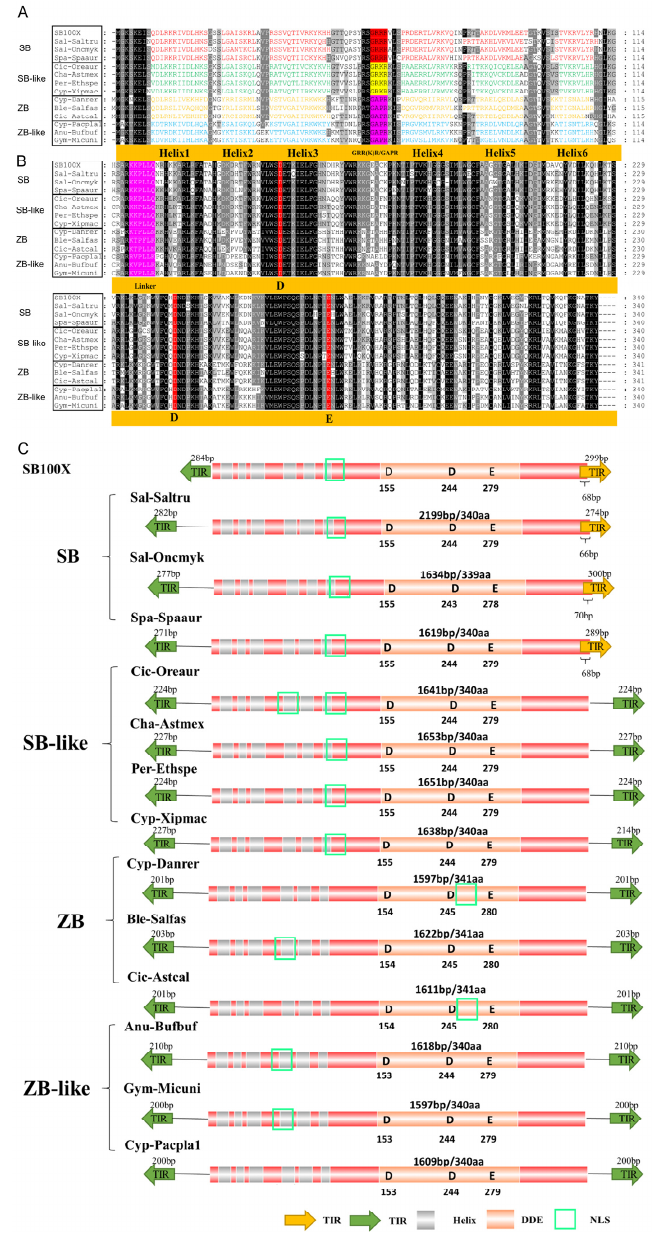
Figure 4. Structural organization of SB and ZB elements. ( A ) Alignment of the DBD domains of SB and ZB transposases. Representative species containing complete transposons were selected for each cluster. Sal-Saltru ( Salmoniformes , Salmo trutta ), Sal-Oncmyk ( Salmoniformes , Oncorhynchus mykiss ), Spa-Spaaur ( Spariformes, Sparus aurata ), Cic-Oreaur ( Cichliformes, Oreochromis aureus ), Cha-Astmex ( Characiformes, Astyanax mexicanus ), Per-Ethspe ( Perciformes, Etheostoma spectabile